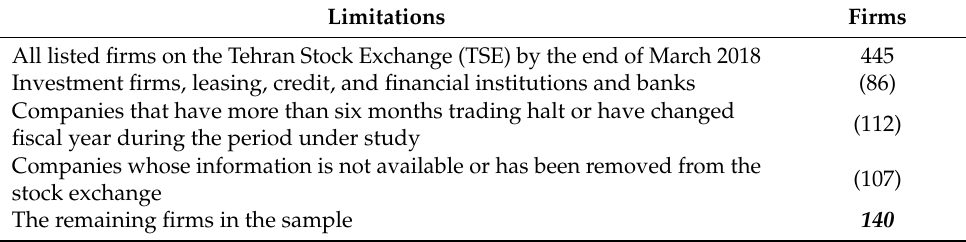
Table 1. The study